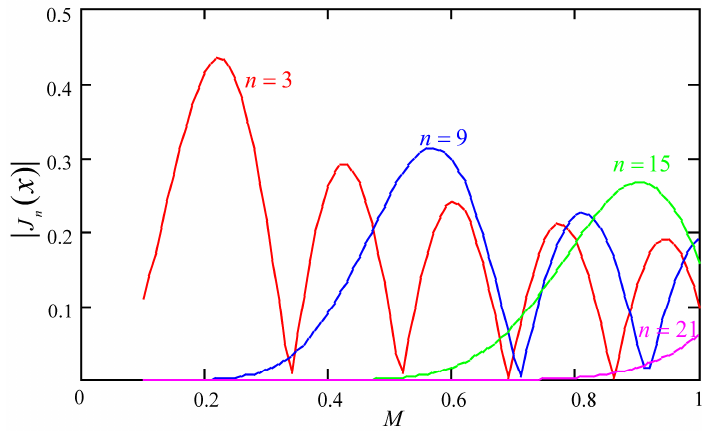
Figure 5. The relationship between Bessel | J n ( x ) | and modulation M